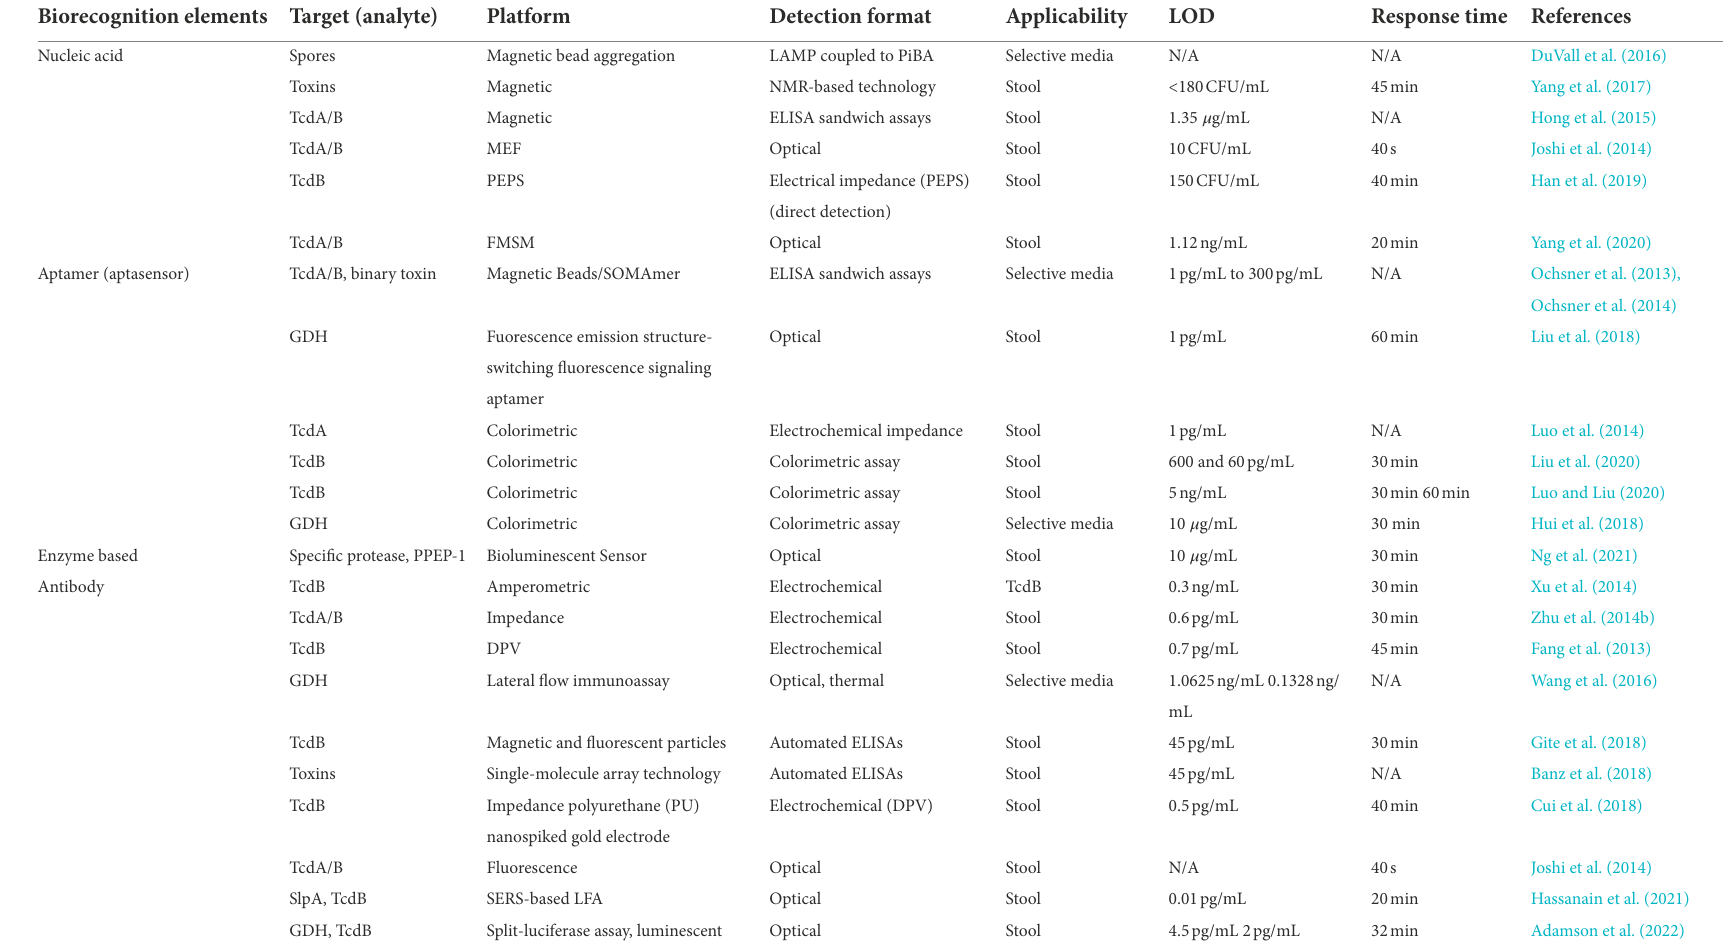
TABLE 4 Examples of rapid detection used for Clostridioides difficile